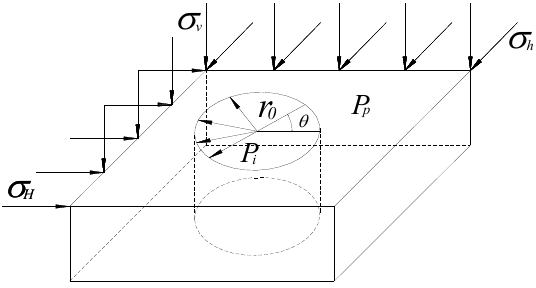
Figure 5. Three ‐ dimensional mechanic model of shaft wall rock . Figure 5. Three-dimensional mechanic model of shaft wall rock.